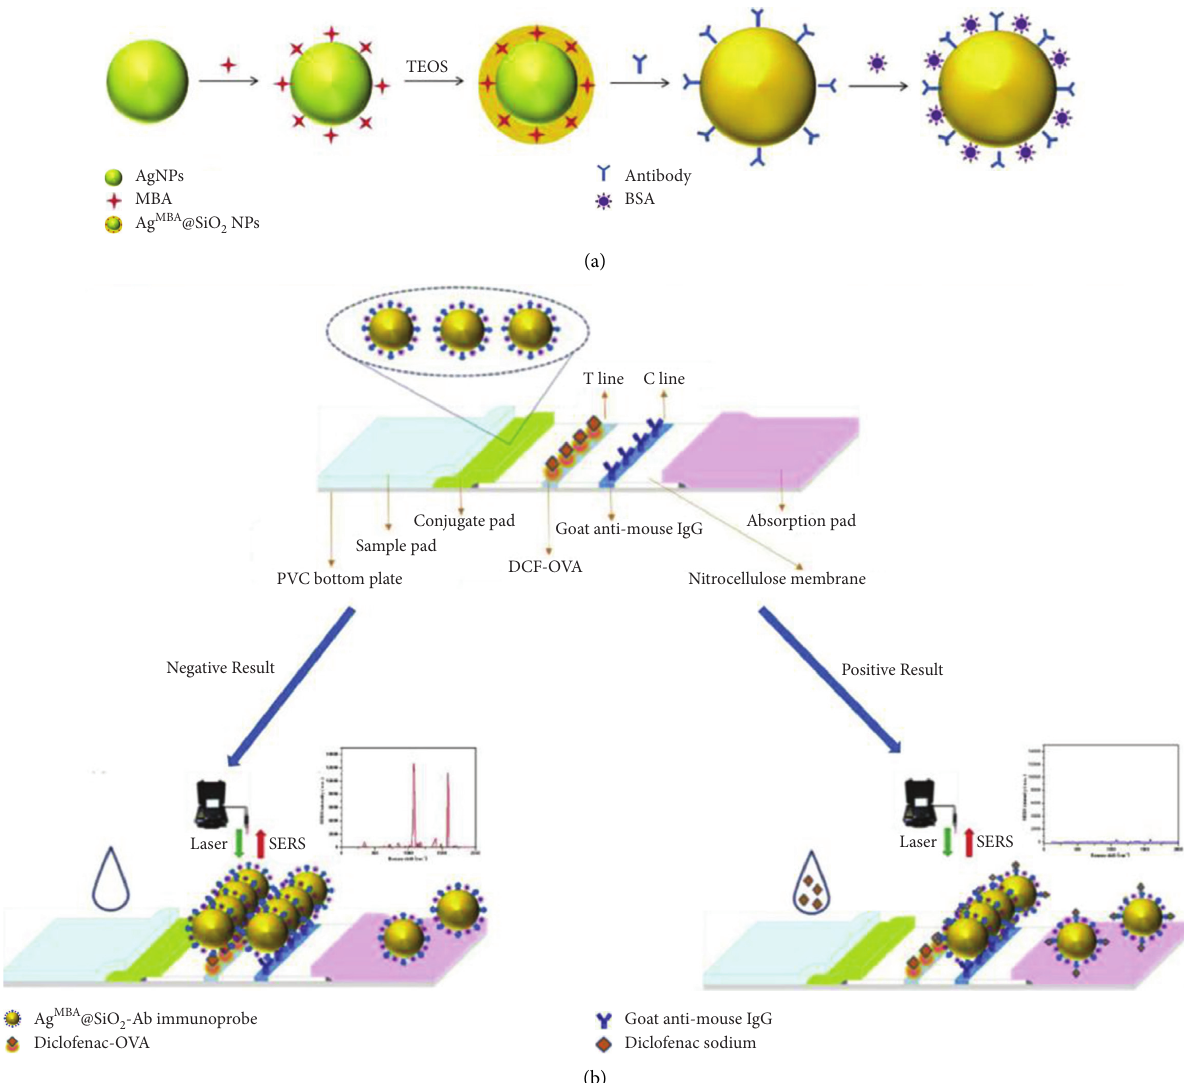
Figure 4: (a) Schematic of the preparation of the immunoprobe (AgMBA@SiO SERS-based ICA for DCF